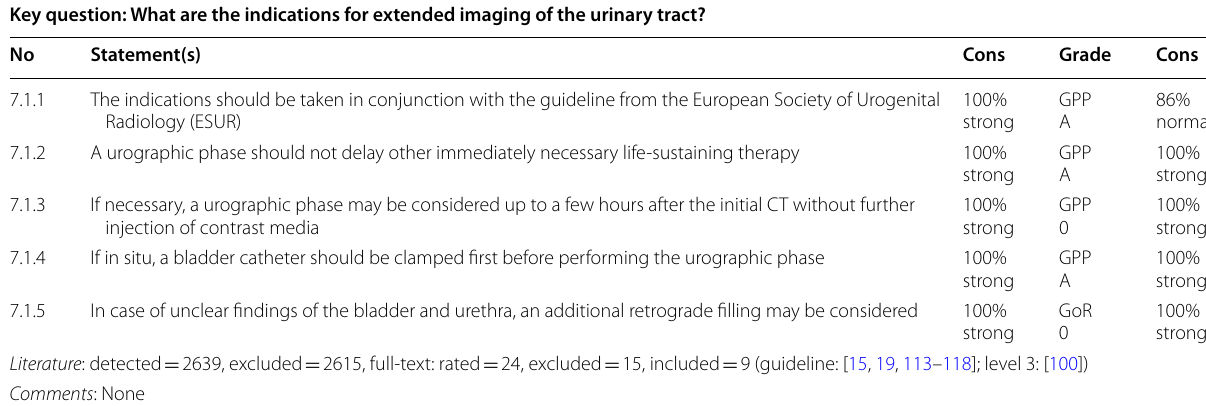
Table 15 Section 7: Whole Body CT – Special protocols, key issue 1: CT—urography Key question: What are the indications for extended imaging of the urinary tract?